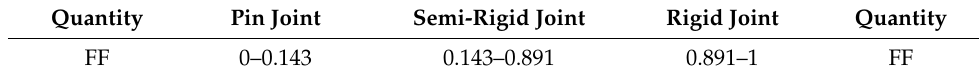
Table 1. Designation of connections concerning FF as per